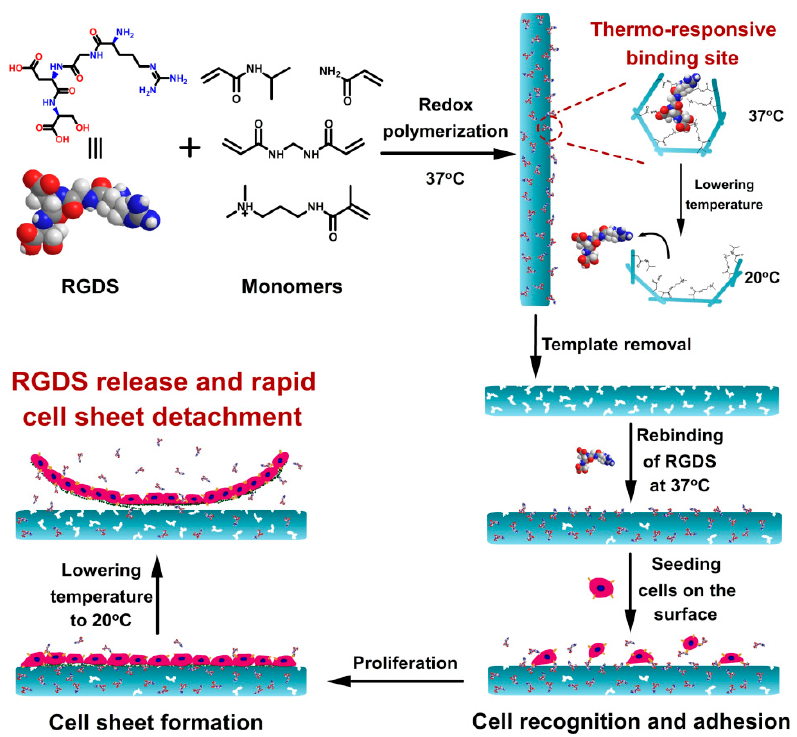
Figure 4. Strategy to introduce the RGDS peptide to a thermo-responsive cell culture substrate by means of molecular imprinting and the schematic illustration for the cell adhesion and the harvesting of a cell sheet. Reprinted with permission from Refence 37. Copyright 2013,